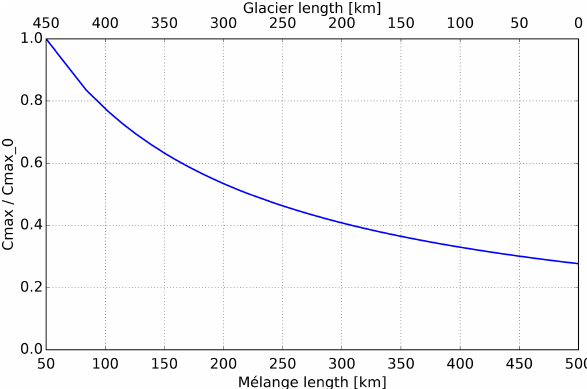
Figure 10. Reduction in the upper limit on calving rates as a func- tion of mélange length and glacier